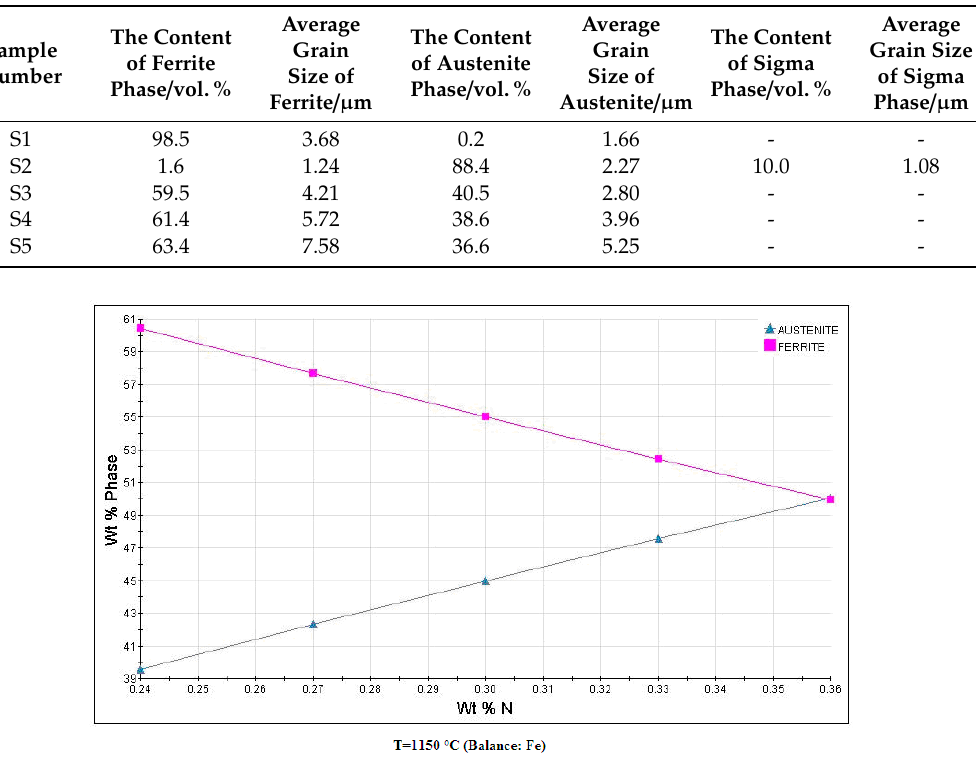
Figure 4. The relationship between nitrogen content and austenite content of UNS S32707 HDSS simulated by JMatPro software.